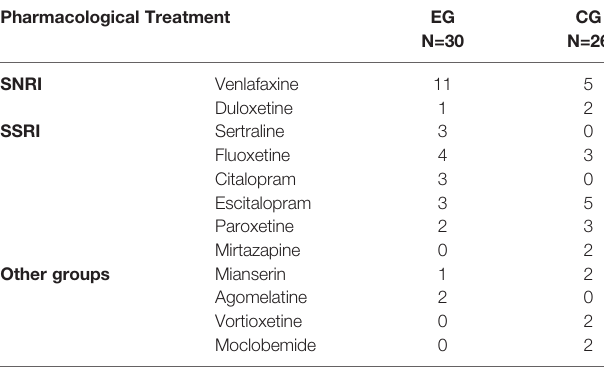
TABLE 2 | Baseline characteristics of pharmacological treatment (n=56).